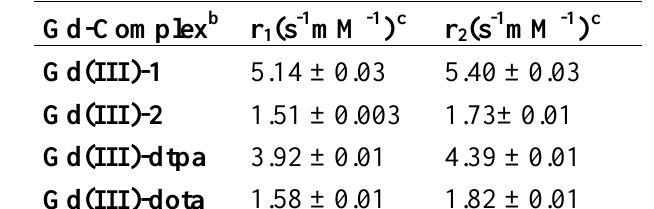
Table 1. Longitudinal and transversal relaxivities (r Gd(III)-complexes of 1 , 2 and Gd(III)-dtpa and Gd(III)-dota determined at